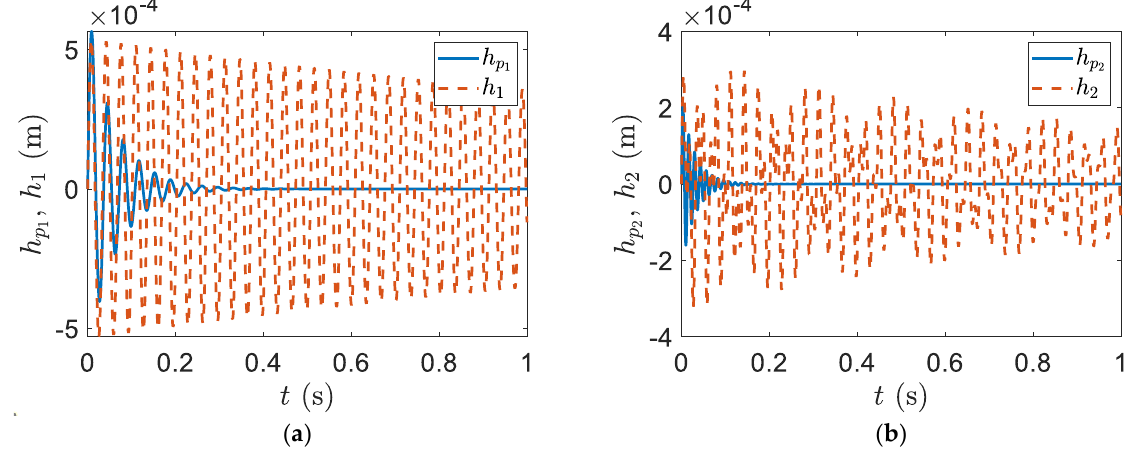
Figure 3. The smart blade system responses of the displacement: ( a ) flapwise oscillation; ( b ) edgewise oscillation.